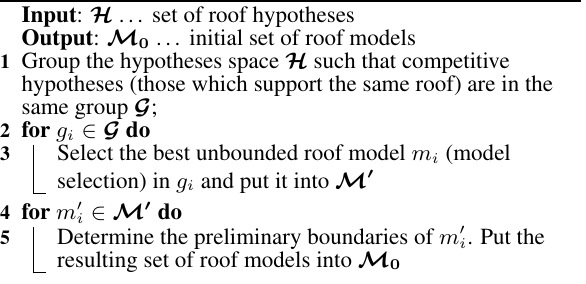
Algorithm 3: Pseudo-code model selection of 3D roofs – SELECT BEST MODELS